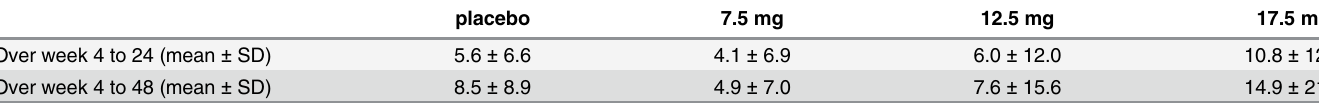
Table 4. Cumulative numbers of newly-emerging Gd + T1 MRI lesions during treatment and follow-up